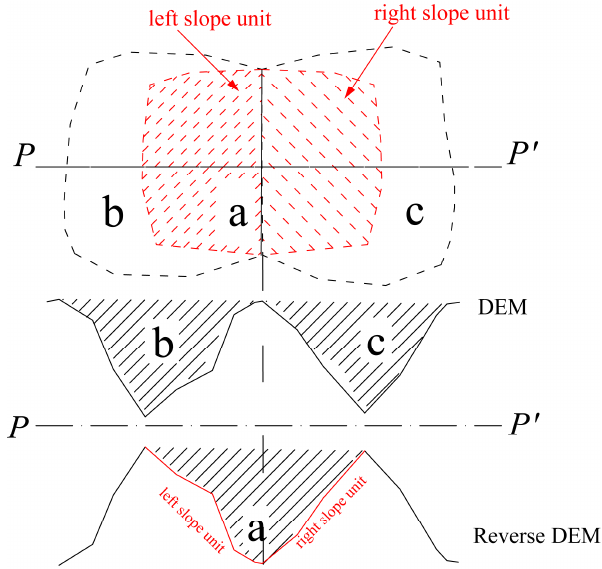
Figure 4. Schematic diagram of slope unit definition from the conventional method (reverse DEM = DEM rotated by 180° along the horizontal plane A-A′). Thus, high DEM values are turned into low values, and low DEM values are turned into high values, and the original drainage line is turned into a ridge line. “a” represents a sub-watershed obtained from the DEM data, and “b” and “c” are the watersheds obtained by the reverse DEM.